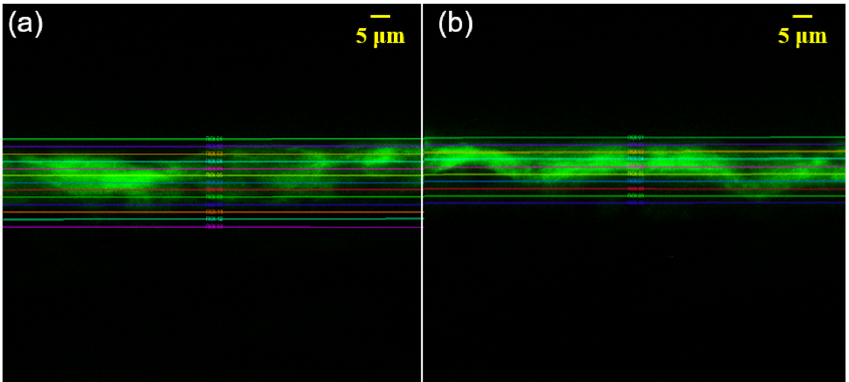
Figure 2. CLSM images of AO-stained PVA-coated papers: coatings on ( a ) the unsized base paper and ( b ) surface-sized base